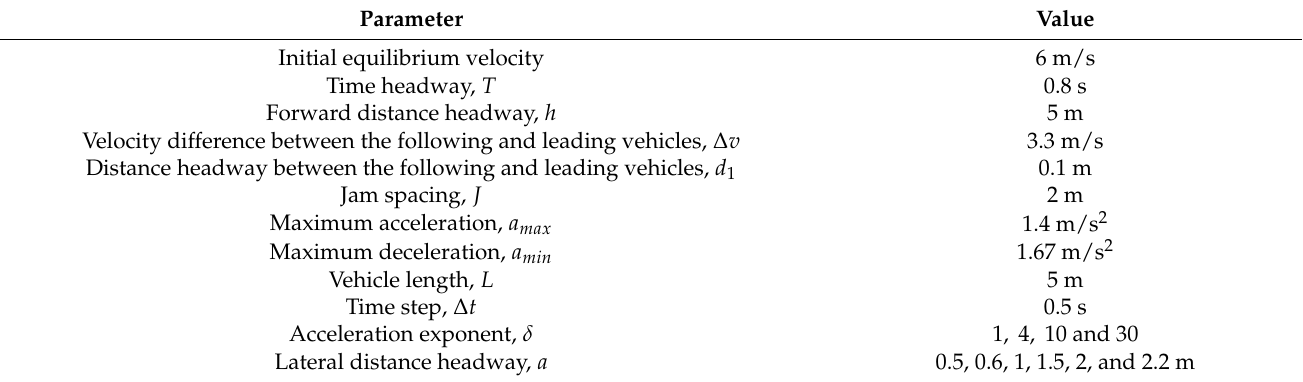
Table 1. Stability analysis